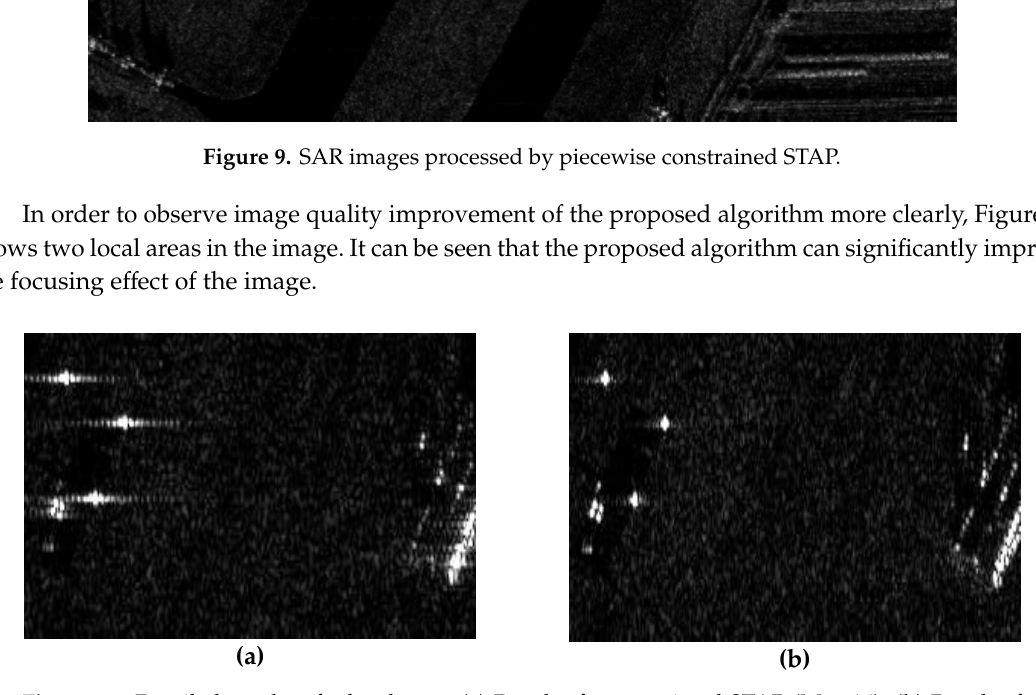
Figure 10. Detailed results of a local area: ( a ) Result of conventional STAP (M = 16); ( b ) Result of PC-STAP (M = 16).